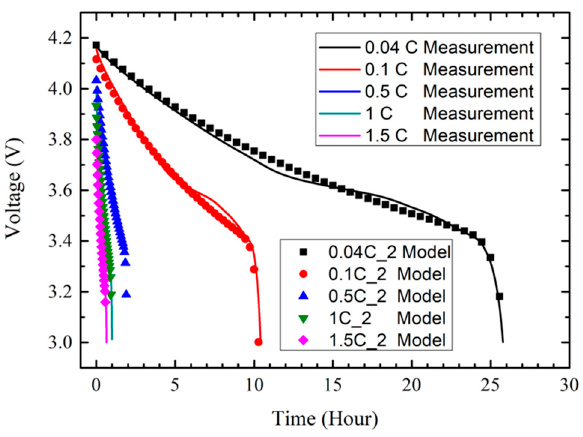
Figure 4. Measurement of L brand 18650.